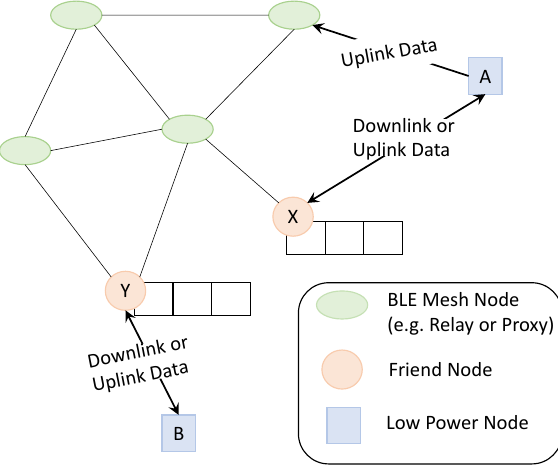
Figure 1. BLE mesh network.